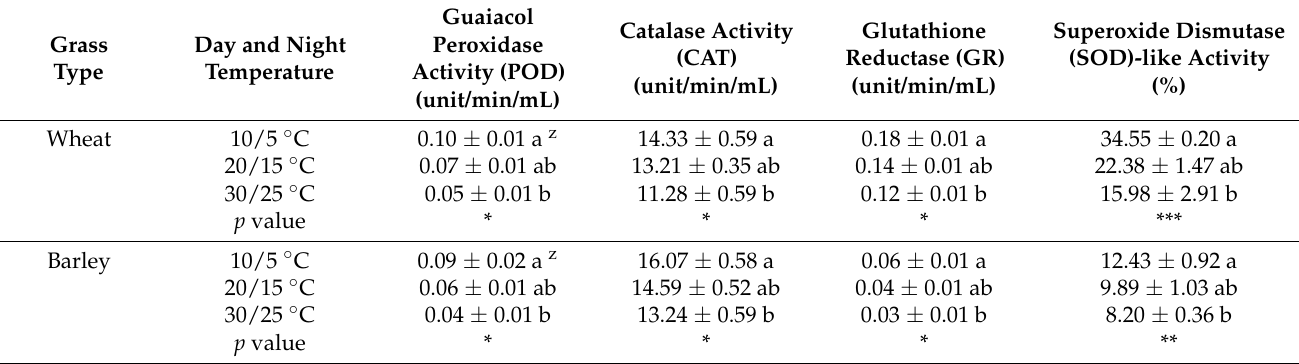
Table 3. Antioxidant enzyme activity of barley and wheat grass extracts treated at different day and night temperatures.